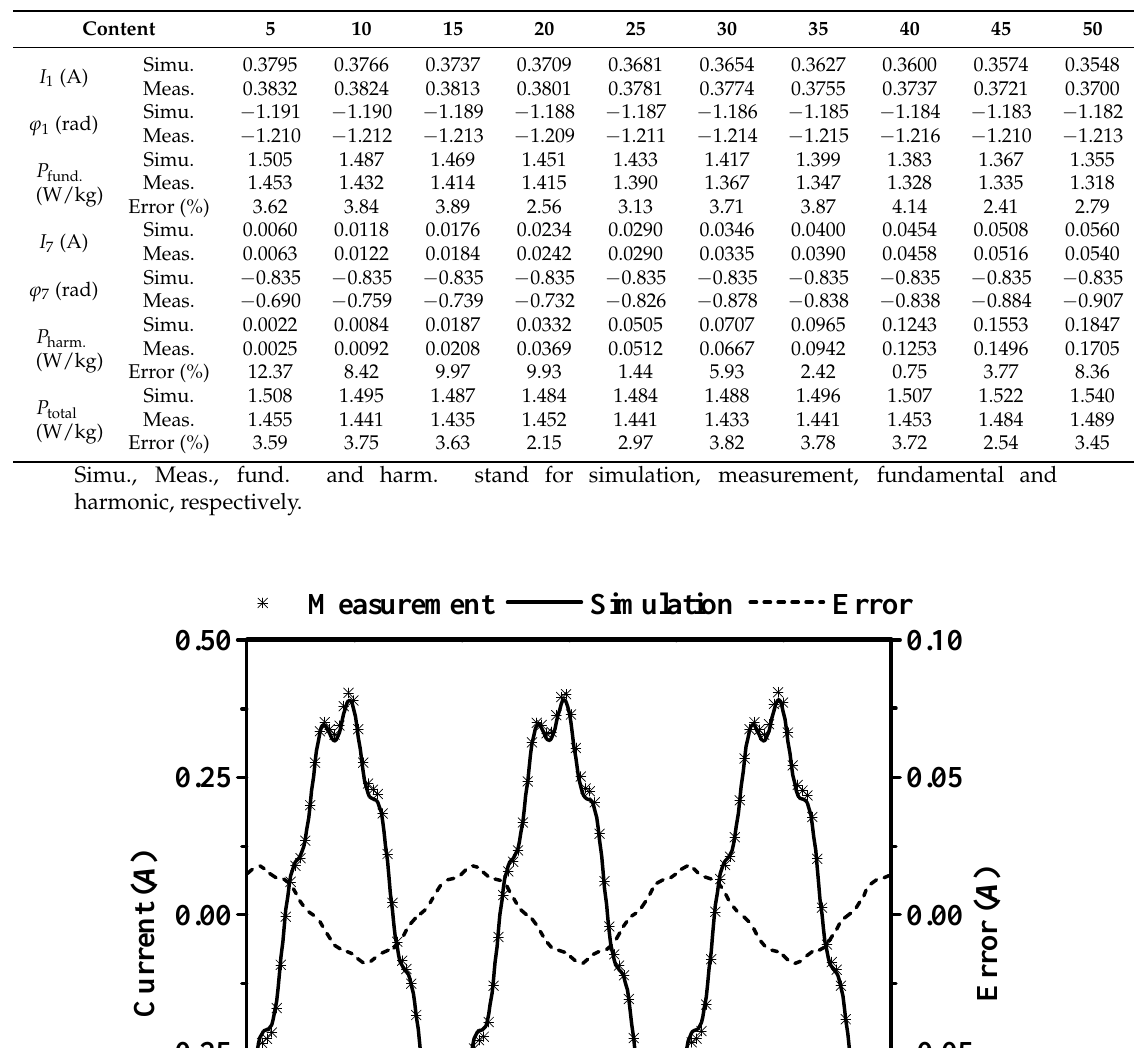
Table 2. Results of 7th harmonic injections into voltage (1.0 T).